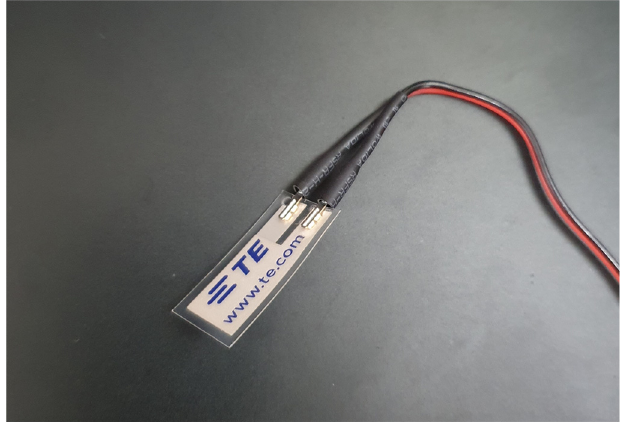
Figure 8. An image of a PVDF sensor (LDT0028K).